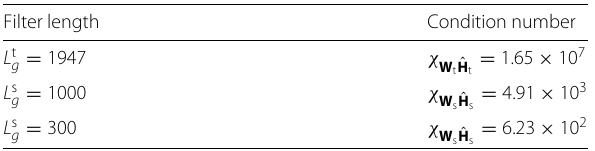
= 1947) and g = 1000 and L s = 300) for PMINT g g